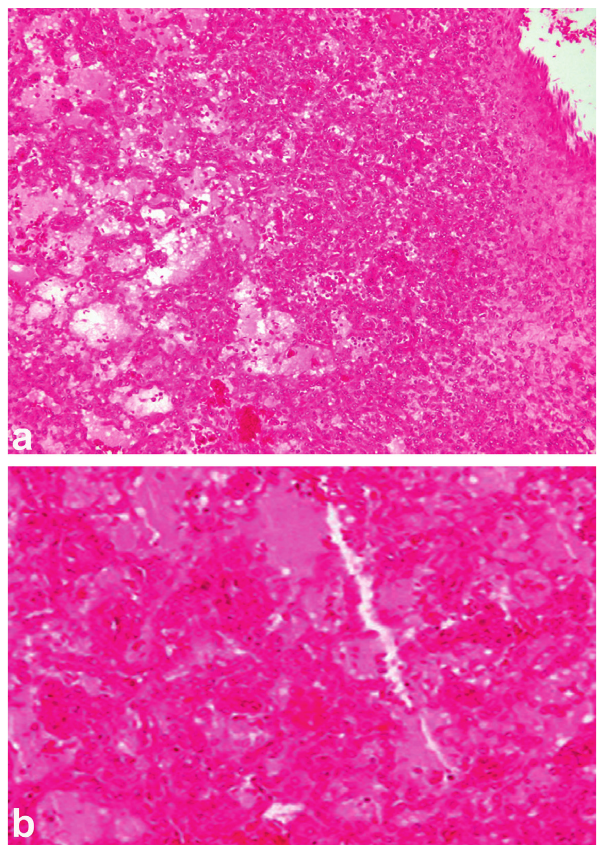
Figure 21: Renal cell carcinoma showing tubular differentiation with malignant epithelial lining and nuclear anaplasia (H&E, image a × 100; image b × 400)